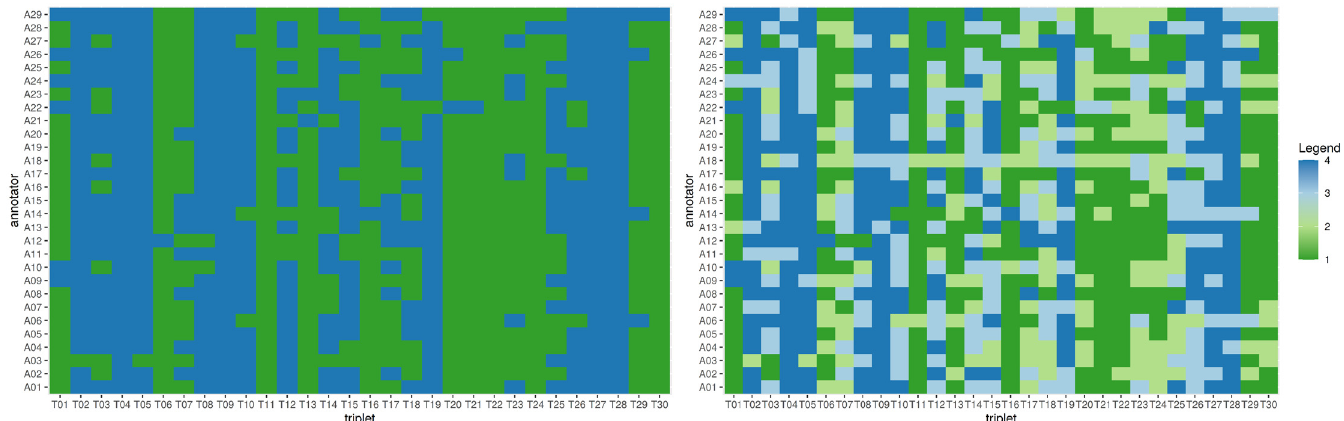
Fig 5. Heatmaps of correctness and Stated_U and correctness. Left subfigure—Heatmap of correctness: green indicates correct annotation of a triplet (x-axis) by an annotator (y-axis), while blue indicates incorrect choice (left subfigure). Right subfigure—refined Heatmap of Stated_U and correctness: correct and certain (1: green intensive), correct and uncertain (2: lime green), incorrect and uncertain (3: light blue), incorrect and certain (4: blue intensive). Some triplets are consistently annotated incorrectly by (almost) all annotators.